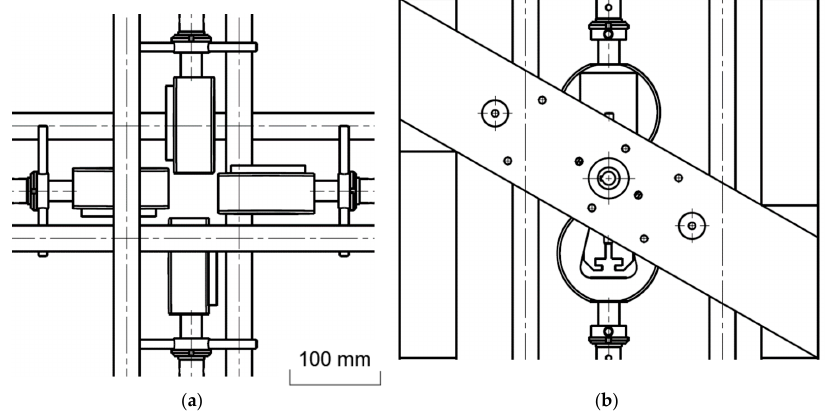
Figure 4. Intermediate solution for the alignment of the plates: ( a ) Frontal view—detail of the visibility and accessibility to the specimen area; ( b ) Lateral view—lateral plate.